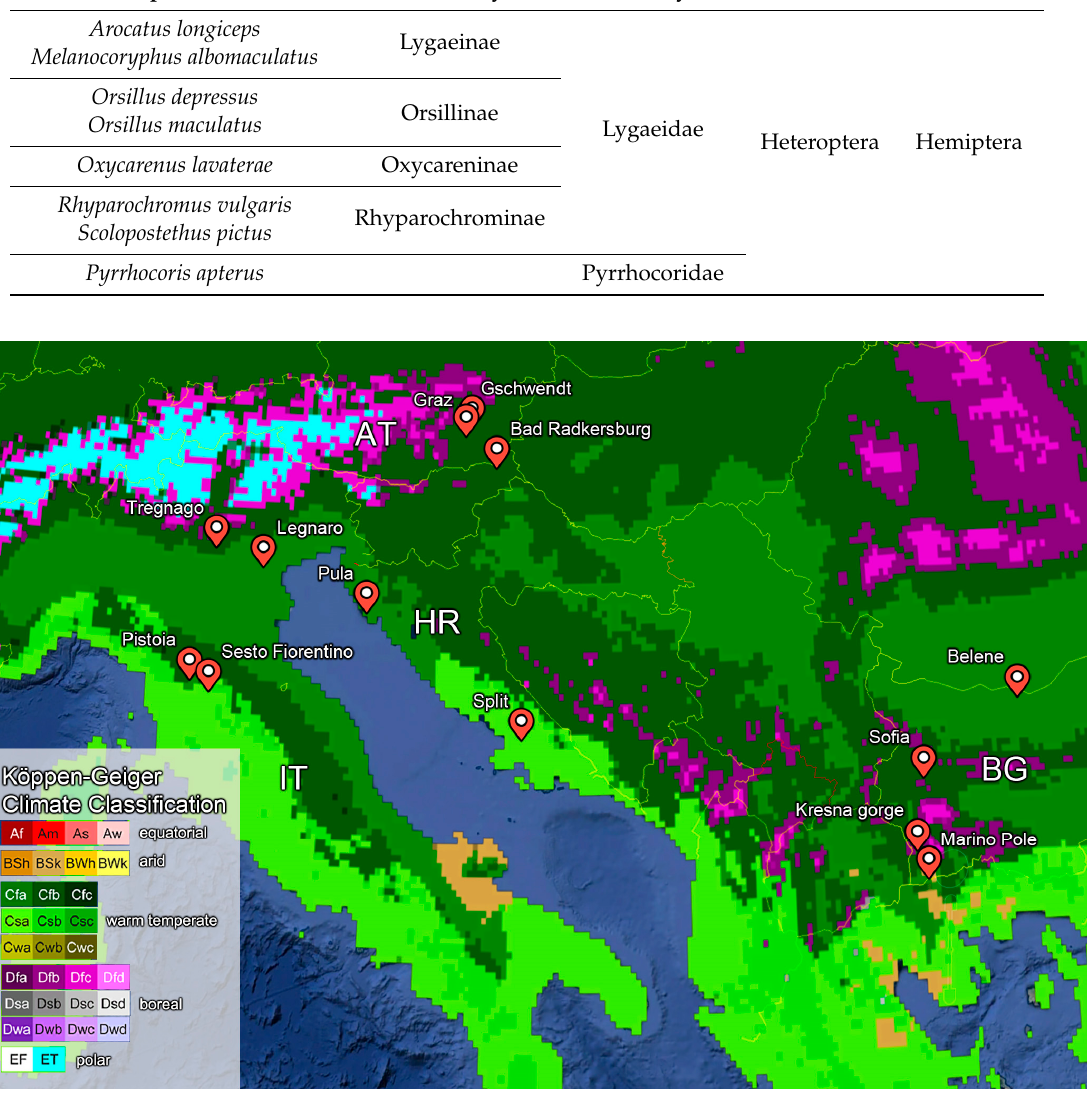
Figure 1. Sample locations and climate regions according to the Köppen–Geiger climate classification (KCC); map modified from Google Earth Pro, KCC overlay from http://koeppen-geiger.vu-wien.ac.at/ [48].